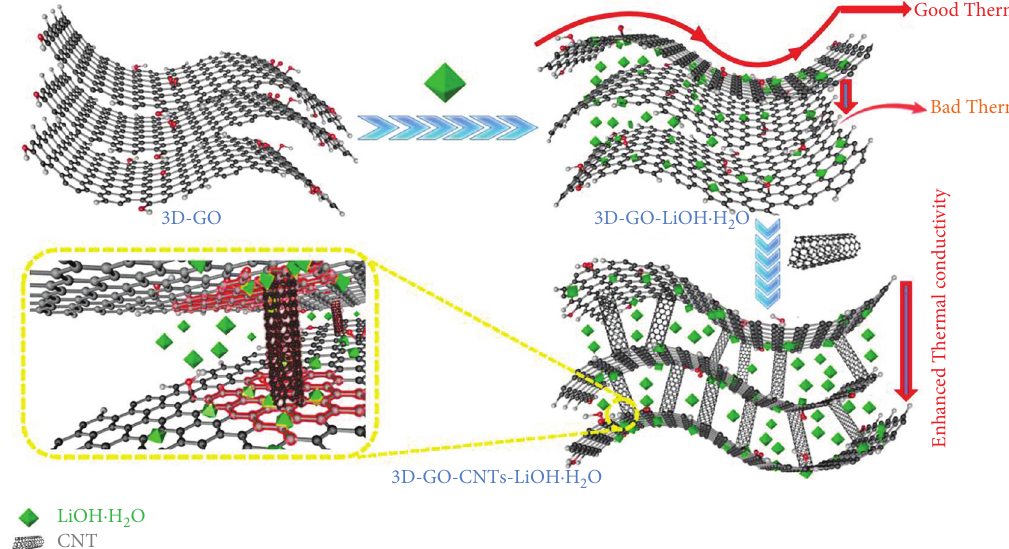
Figure 1: Enhanced thermal conductivity perpendicular to the GO surfaces.